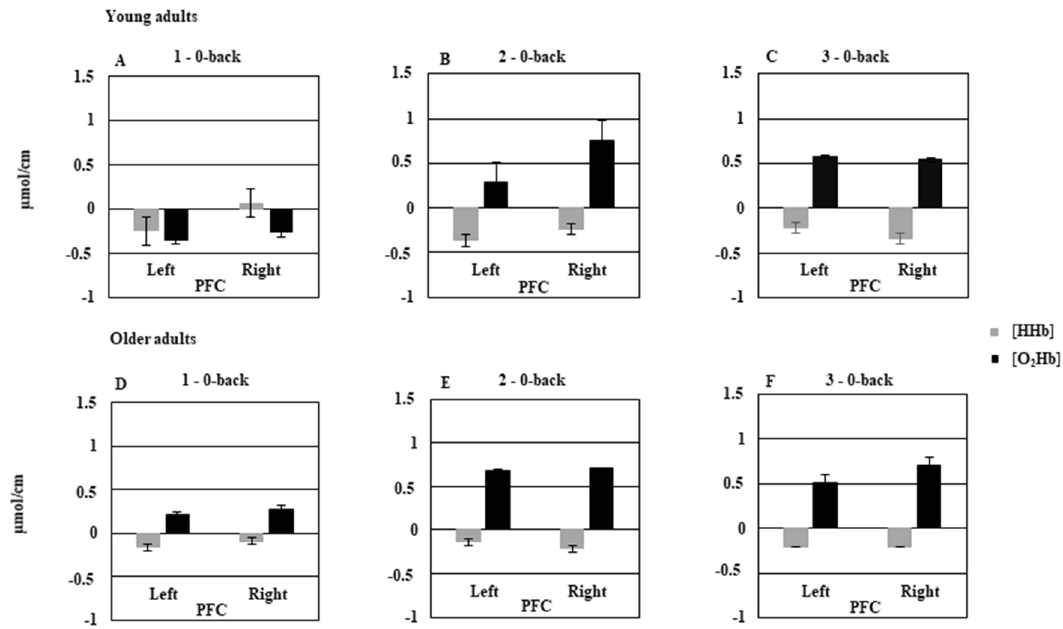
Figure 2. Hemodynamic concentration changes in prefrontal cortex (PFC) of young adults and older adults as a function of cognitive load ( A = 1–0-back; B = 2–0-back; C = 3–0-back in young adults and D = 1–0-back; E = 2–0-back; F = 3–0-back in older adults) and hemisphere. Bars represent standard